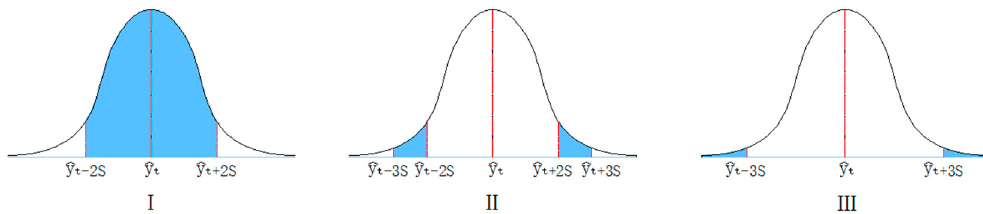
Figure 2. Interval distribution diagram of three safety classes of dependent variables.